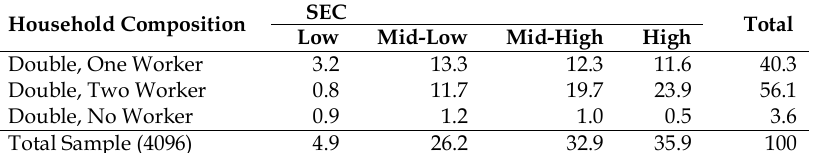
Table 2. Distribution of households across household composition and SEC (%)